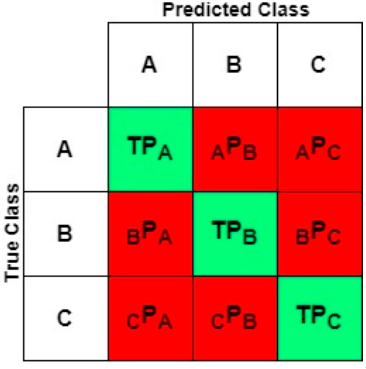
Figure 3. Confusion matrix.